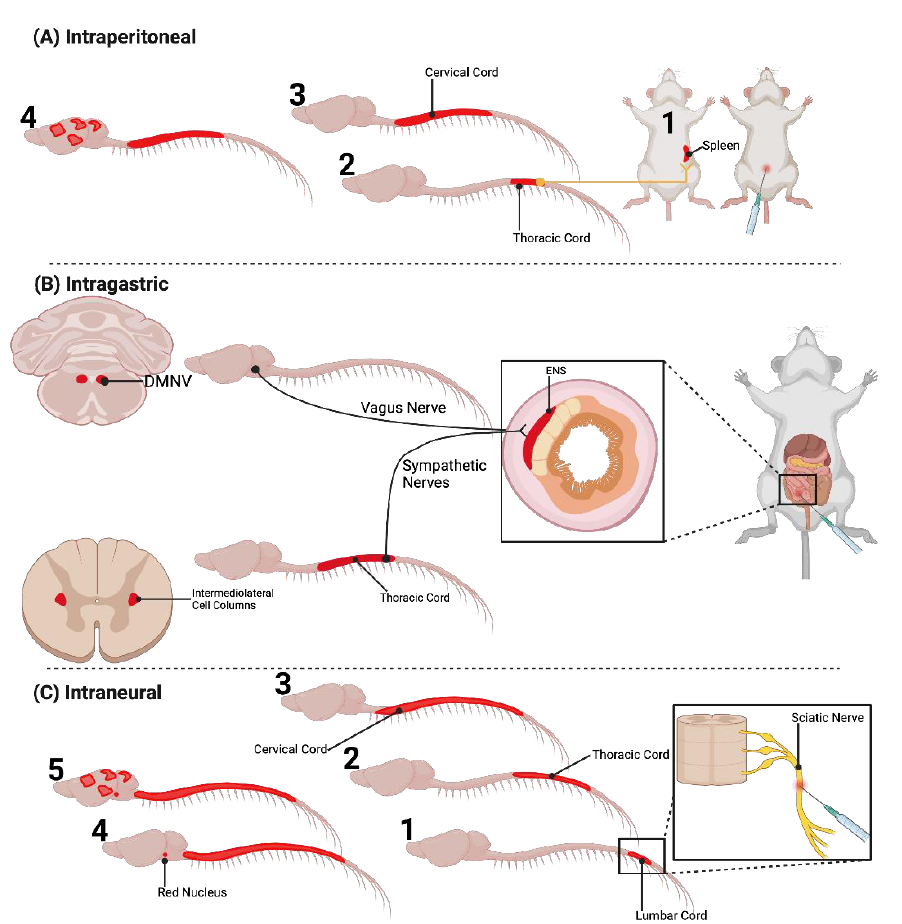
Figure 2. Prions spread along defined neuroanatomical pathways. ( A ) Prions inoculated through the intraperitoneal route (i.p.) initially accumulate in the spleen (1) before spreading along autonomic nerves into the thoracic spinal cord (2). Subsequent spread is rostrally within the spinal cord (3) to the brainstem and eventually into the brain (4). ( B ) Intragastric prion inoculation results in PrP Sc accumulation in the myenteric plexus of the enteric nervous system (ENS) then subsequent spread along sympathetic efferent nerves to the thoracic spinal cord or directly to the dorsal motor nucleus of the vagus (DMNV) via parasympathetic vagal efferents. As with i.p. routes, spread occurs rostrally within the spinal cord to the brain. ( C ) Intraneural infection of prions results in spread along defined neuroanatomical pathways. In the case of the sciatic nerve, prion spread occurs along nerve roots to the VMNs of the lumbar spinal cord (1). Subsequent spread of prions in the spinal cord occurs in the rostral direction (2 and 3) toward brainstem nuclei that include the red nucleus (RN), vestibular nucleus, and cortex (4 and 5). Image created with BioRender.com, accessed on 28 February